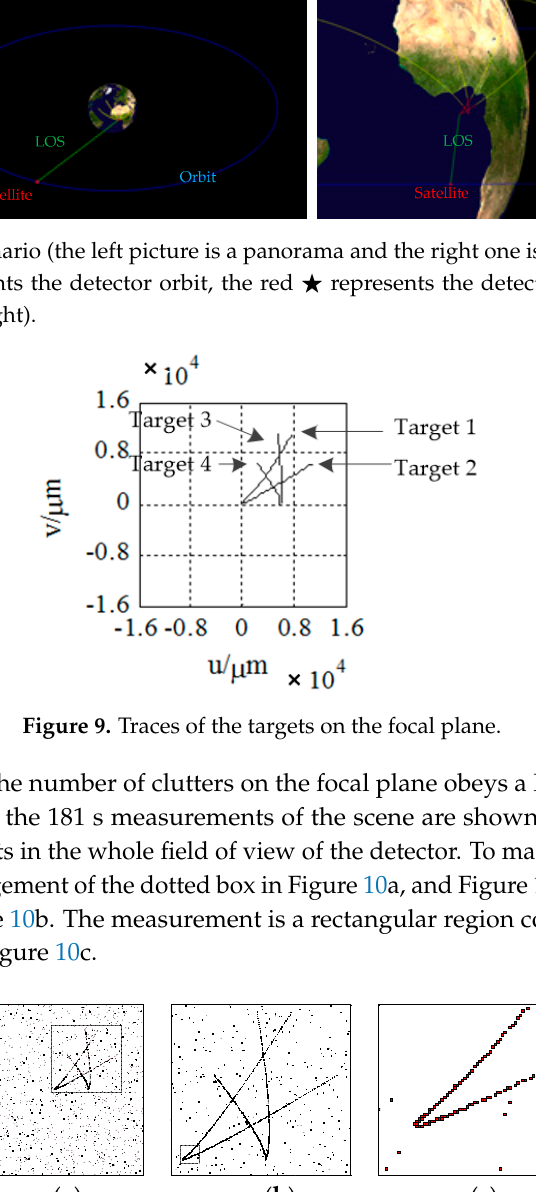
lines represent the free-flight phases.).